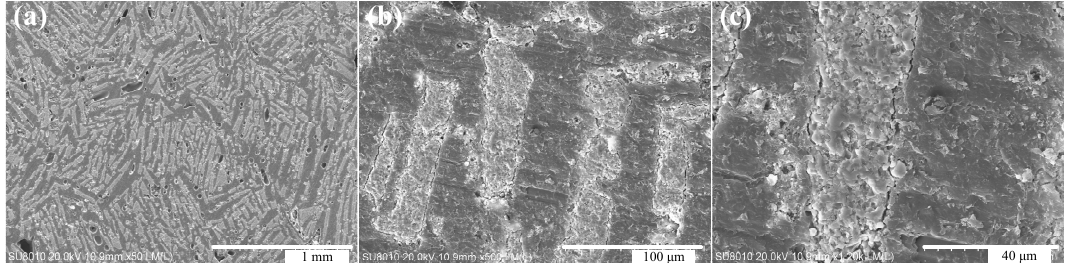
Figure 4. ( a – c ) Microscopic morphology of 20% wt. % layered Al 2 O 3 /PMMA composite with different magnification.